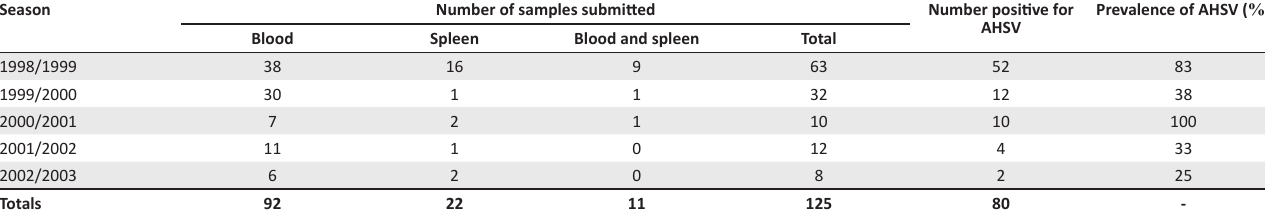
TABLE 3: Horse samples submitted by private equine veterinary practitioners for the detection of African horse sickness virus antigens.